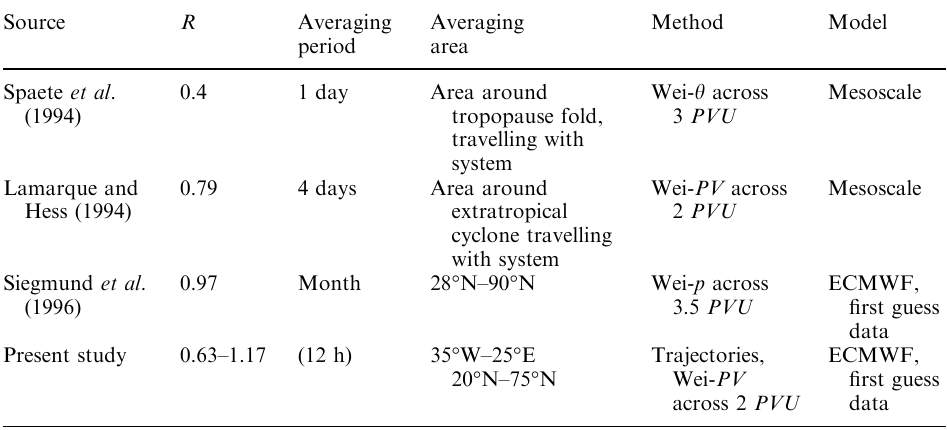
Table 2. Calculations of R (=| F up/ F down|) from previous studies and the present stud